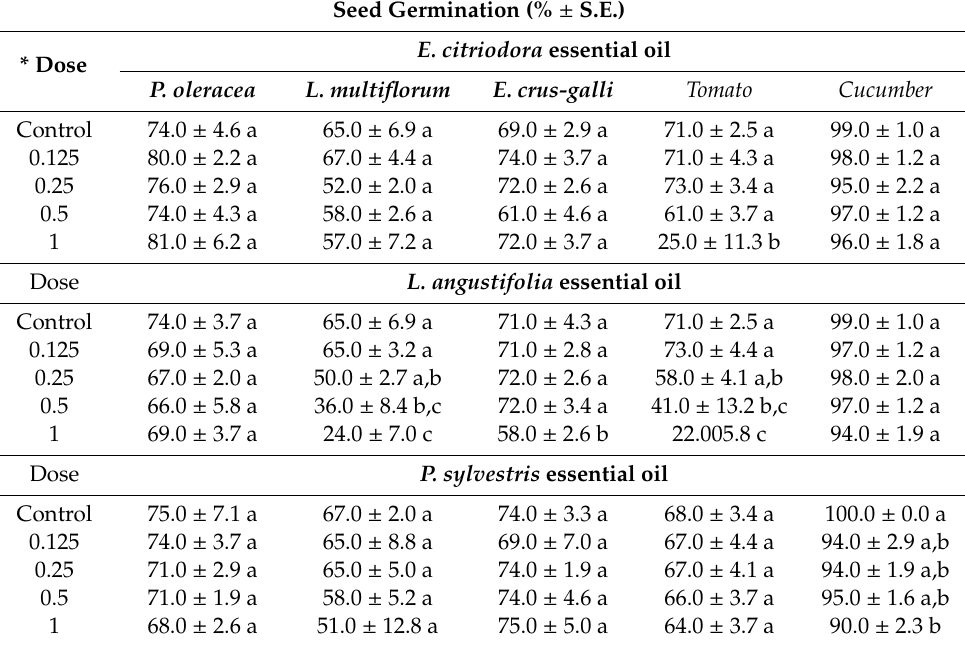
Table 2. In vitro phytotoxic e ff ect of di ff erent doses of E. citriodora , L. angustifolia , and P. sylvestris essential oils on Portulaca oleracea , Lolium multiflorum , Echinochloa crus-galli, tomato, and cucumber seed germination. Seed Germination (% ±